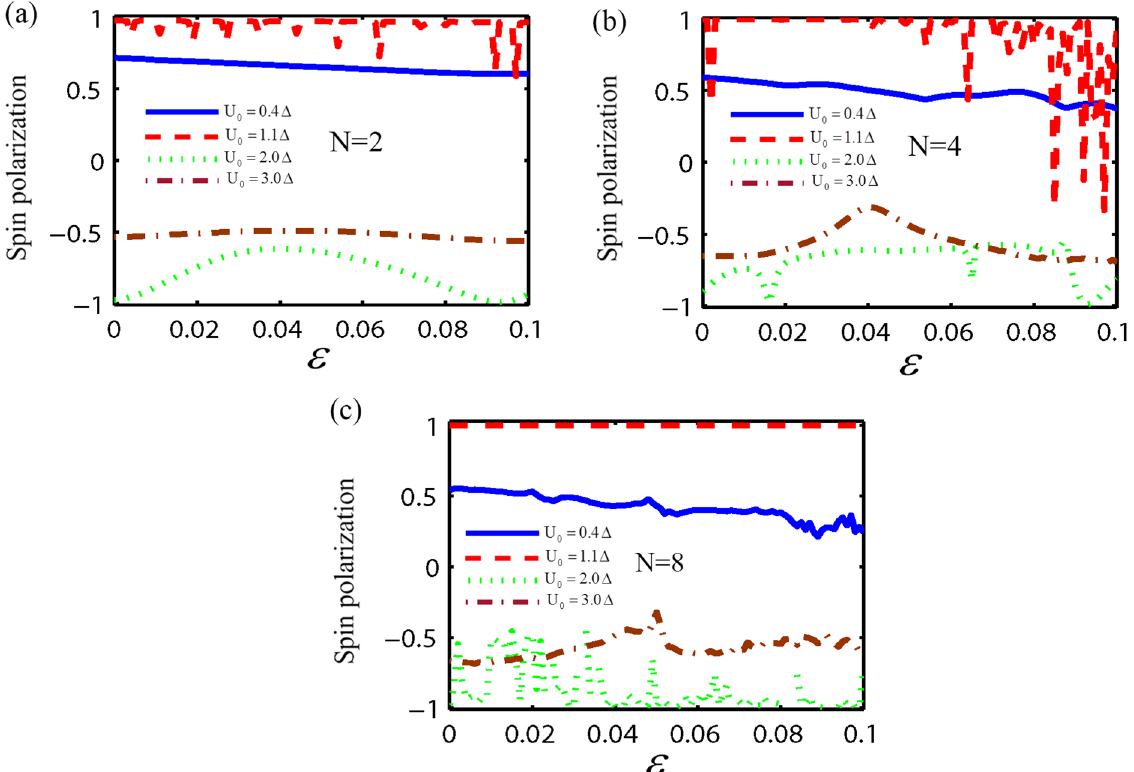
Figure 4. The spin polarization as a function of ε with several values of the height of the electrostatic potential barrier, for fixed E = 1.5 (cid:31) , (cid:31) R = 50 meV, k F 0 b = 5 and k F 0 w = 3. For ( a ) two barrier, ( b ) four barriers, and ( c ) eight barriers